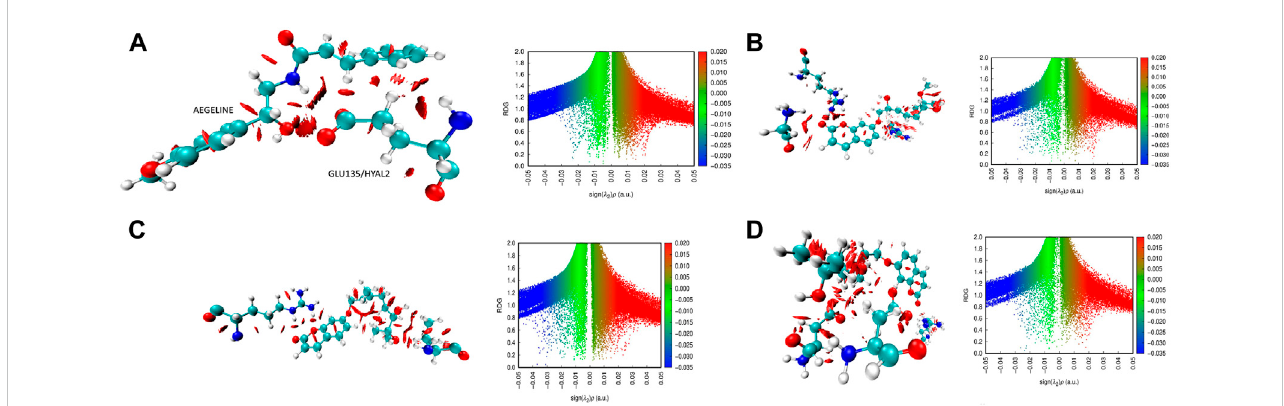
FIGURE 7 (A) :NCIisosurfaceplotfortheHYAL-2-aegeline, (B) :NCIisosurfaceplotfortheHYAL3-marmenol,thepresenceofblueregionswithintheplotdenotes the existence of strong interactions like hydrogen bonds. The presence of red regions in the plot shows thepresence of steric effects due to strong repulsion interactions.ThegreenregionsdenotedthepresenceofweakbondingsuchasvanderWaalinteractions. (C) :NCIisosurfaceplotandRDGplotfortheHYAL4- marmin, (D) : NCI iso surface plot for the HYAL-PH20- marmin.